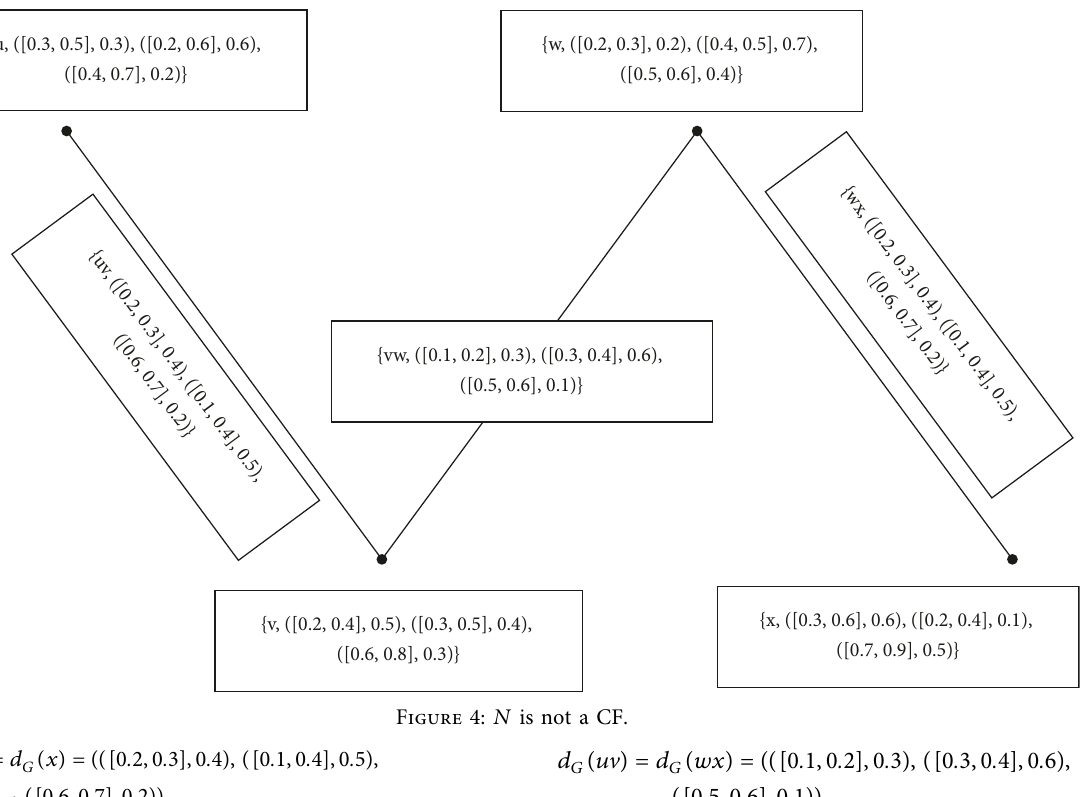
Figure 4: N is not a